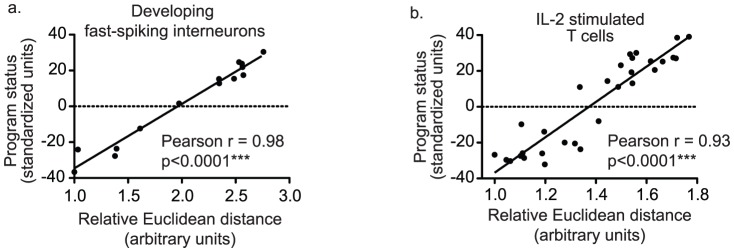
Program progression is linearly correlated with dissimilarity measures.Euclidean distance (x-axis) for each transcriptome was calculated from an index transcriptome with the lowest value for PCA1. Euclidean distance was used as a measure of absolute dissimilarity. Distance was plotted against program status (y-axis) to demonstrate a linear relationship between program status (increasing PCA1) and dissimilarity (Euclidean distance) for gene expression programs in developing fast-spiking interneurons (4a) and IL-2 stimulated T cells (4b).